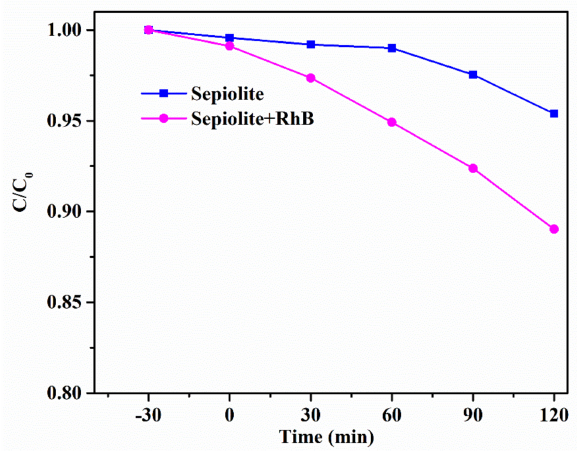
Figure 10. Removal efficiency of TB by sepiolite and spent RhB-sepiolite after adsorption of RhB under the visible light irradiation. The initial concentrations of RhB and TB were 2 × 10 − 5